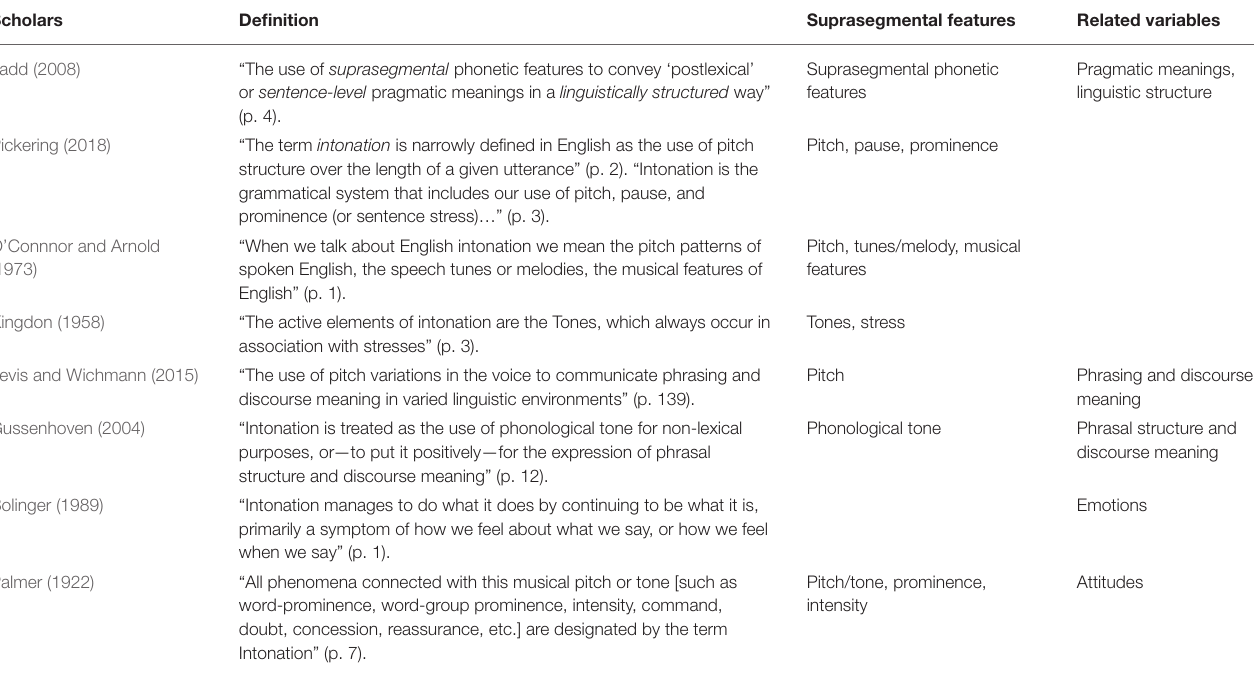
TABLE 1 | Scholars’ definitions of intonation and the suprasegmental features